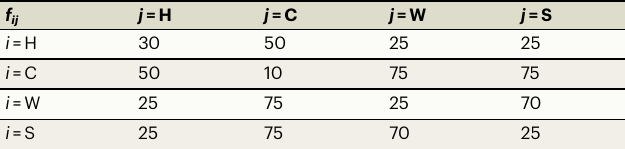
Table 2 | DPD force parameters f ij in units of k B T /